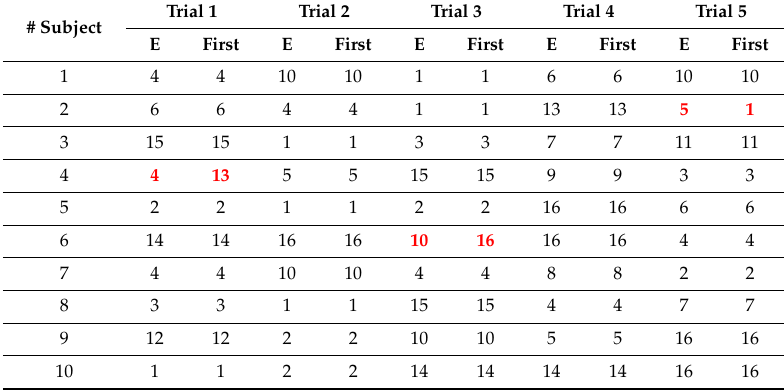
Table A1. Comparison between algorithm and experts with regard to the identification of the first relevant channel.